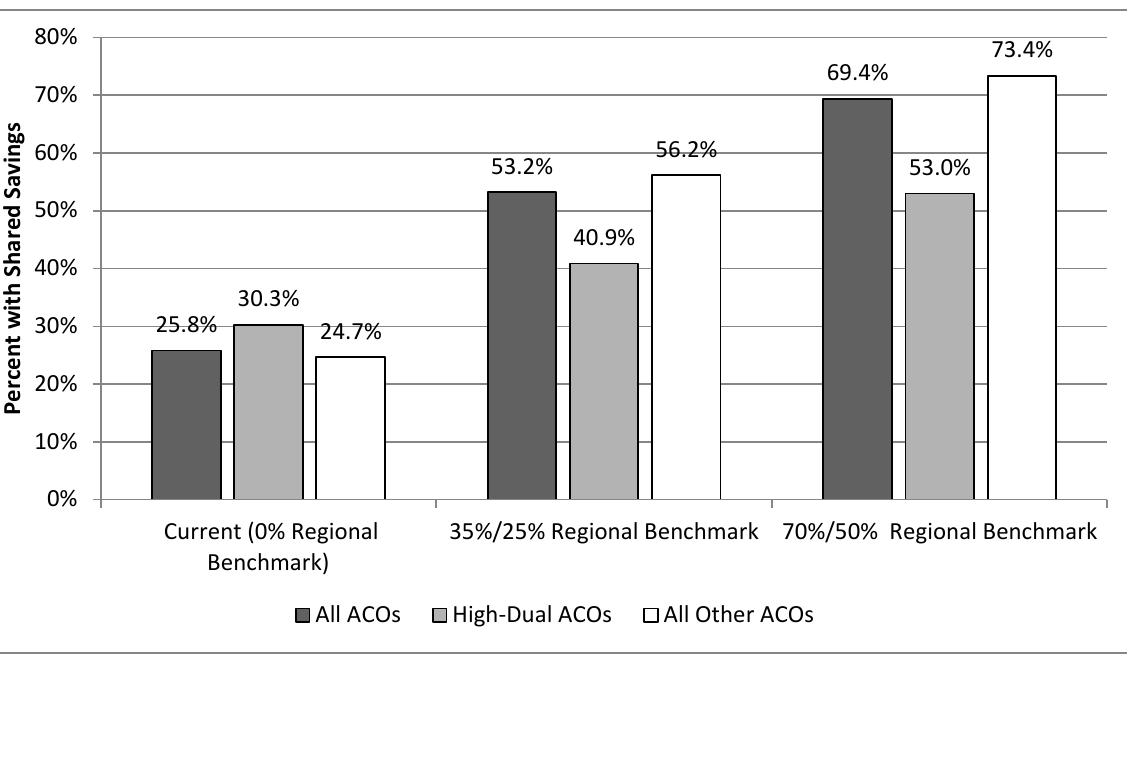
Figure 9.6: Percent of ACOs Achieving Shared Savings under Regional